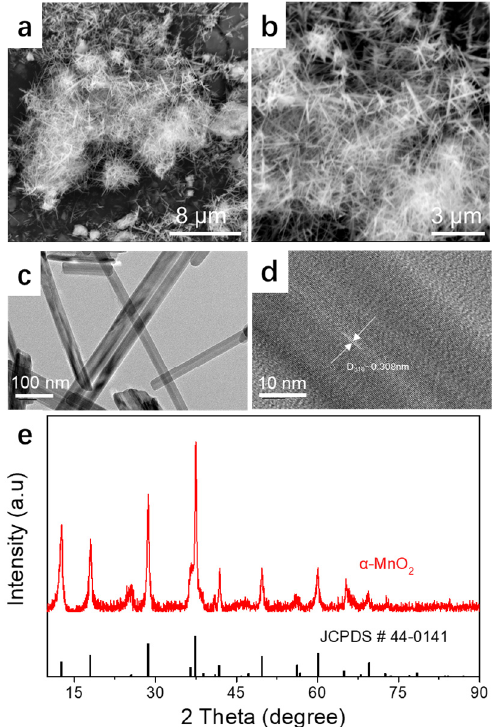
Figure 1. Physical properties of the prepared MnO 2 : ( a , b ) SEM images; ( c , d ) TEM images; ( e ) XRD patterns.